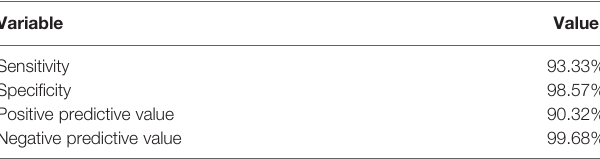
TABLE 4 | Accuracy of using intrahepatic bile duct dilation in HCC patients for BDTT diagnosis.